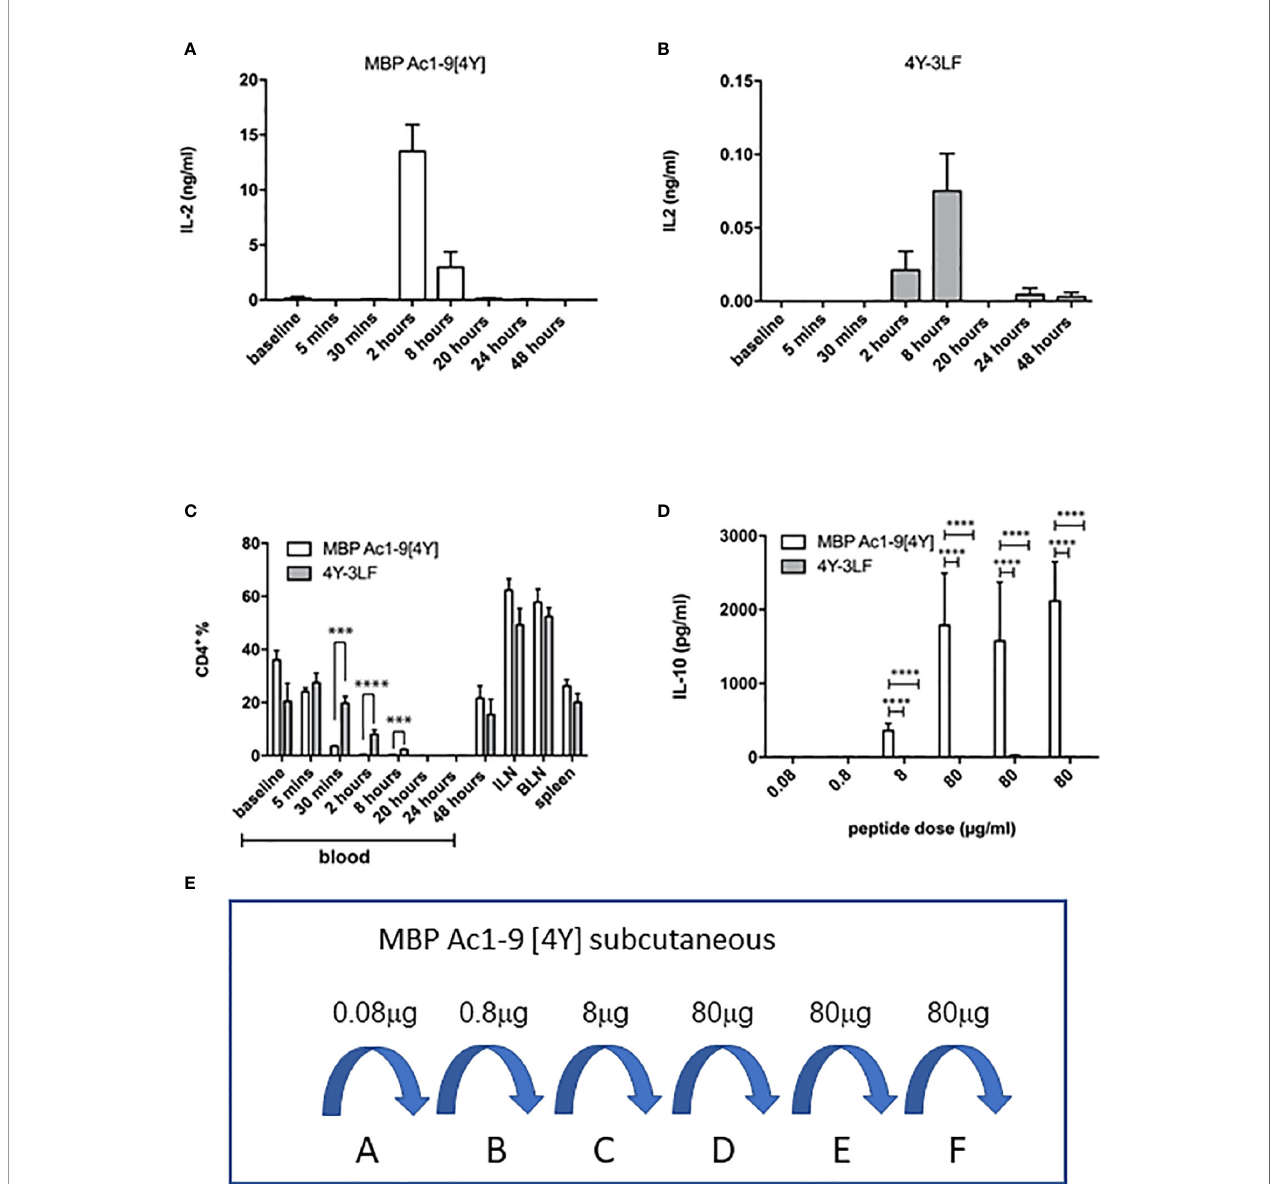
FIGURE 3 | Impact of soluble versus insoluble peptide treatment on T cell function in Tg4 mice. A single SC dose of soluble 4Y (80µg) induces rapid and high levels of IL- 2 into the serum of Tg4 mice (A) when compared to insoluble 4Y-3LF (B) . For the data shown in (C) , Tg4 mice received a SC injection of 80µg MBP Ac1-9[4Y] or 4Y-3LF. Blood was removed from the tail vein at the speci fi ed times following injection, baseline was taken prior to peptide injection and the cellular fraction was stained for fl ow cytometry. Inguinal lymph node (ILN), brachial lymph node (BLN) and spleen were collected at 48 – hours. Percentages of CD4 + cells were gated on live singlets. Dose escalation of 4Y peptide given SC using the protocol shown in (3E) induced high levels of IL-10 secretion into blood (D) that was not seen in mice treated with 4Y-3LF (open bars = 4Y; fi lled bars = 4Y-3LF), error bars show SEM. (*p ≤ 0.05, **p ≤ 0.01, ***p ≤ 0.001, ****p ≤ 0.0001). (E) shows the dose escalation protocol used for tolerance induction in (D) . Tg4 mice were given SC injections of PBS containing the indicated doses of 4Y peptide given every 3 rd or 4 th day (2 doses per